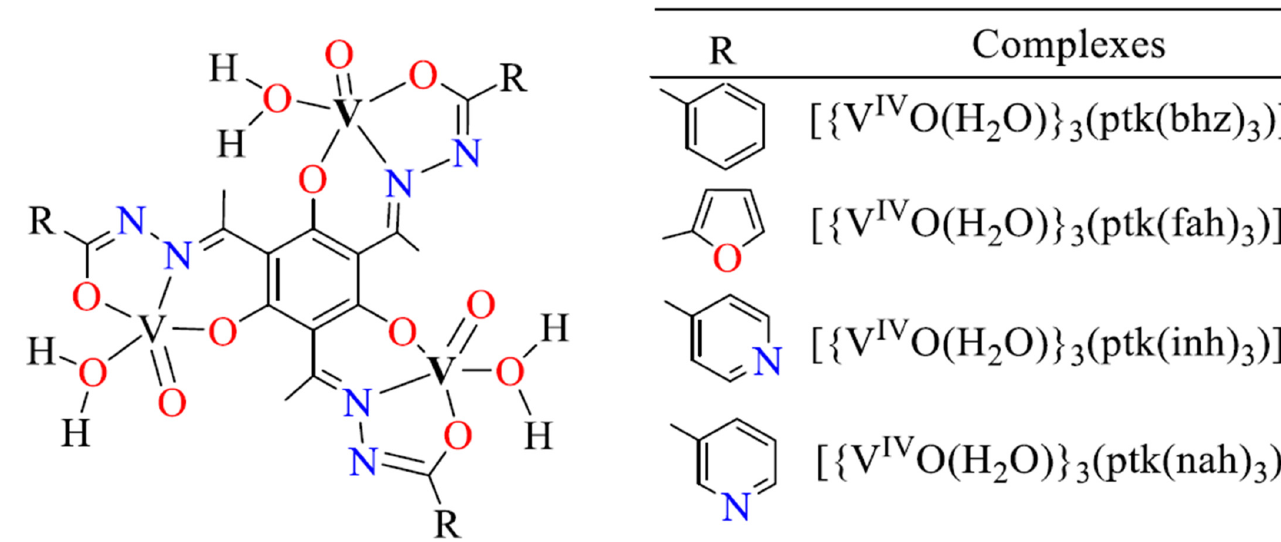
Figure 25. Effect of the heating mode (MW irradiation or oil bath) on the total yield of cyclohexanol and cyclohexanone obtained by neat oxidation of cyclohexane with aq. H 2 O 2 catalyzed by complex 30 , adapted from Ref. [159], Copyright (2019) with permission of Royal Society of Chemistry.